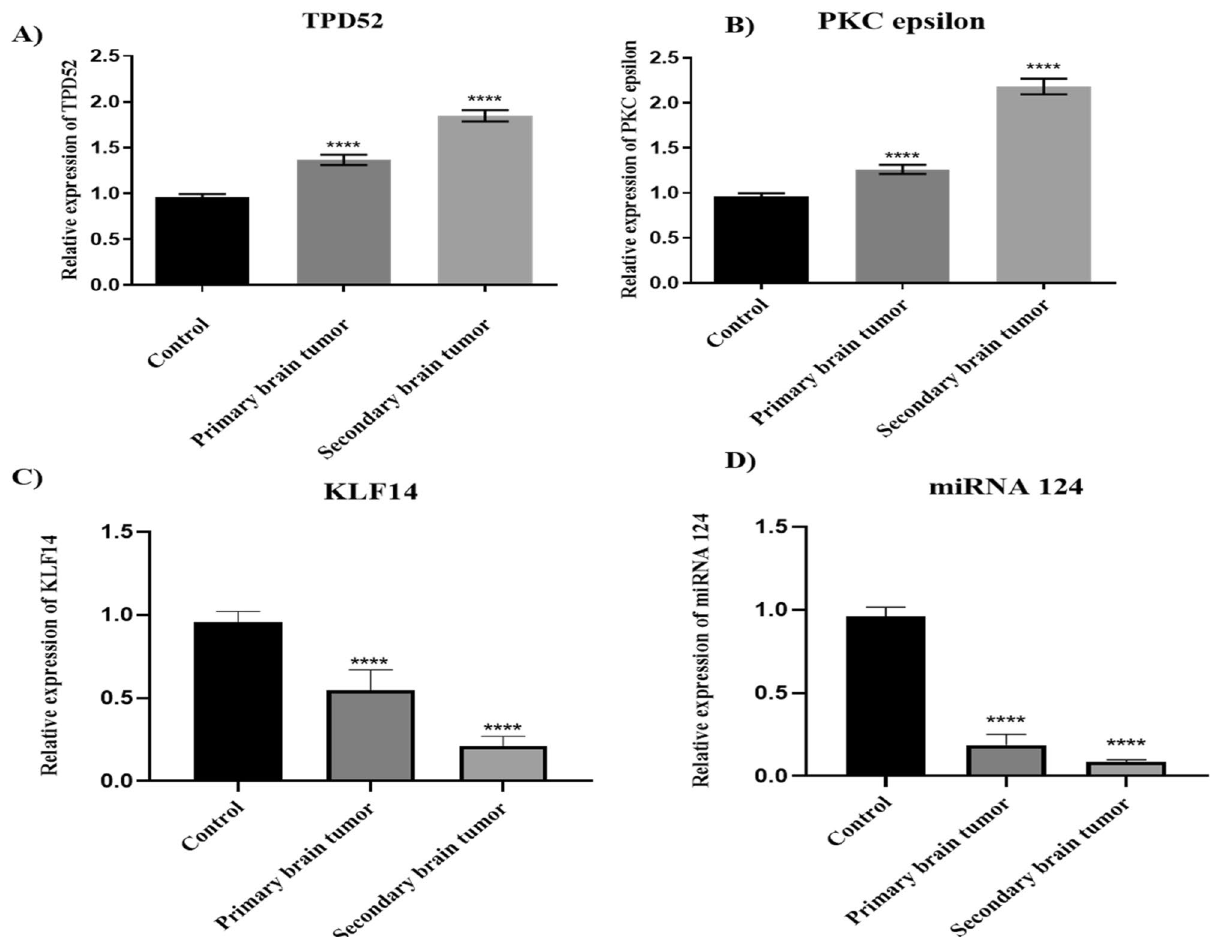
Figure 3. Expression of TPD52, PKCε, KLF14 and miRNA124 in primary and secondary groups of brain cancer. ( A ) Expression of TPD52 in metastatic and non-metastatic groups of brain cancer patients compared to healthy controls; ( B ) Expression of PKCε in metastatic and non-metastatic groups of brain cancer patients compared to healthy controls; ( C ) Expression of KLF14 in metastatic and non-metastatic groups of brain cancer patients compared to healthy controls; ( D ) Expression of miRNA 124 in metastatic and non-metastatic groups of brain cancer patients compared to healthy controls. There is an elevated expression of TPD52 and PKCε in metastatic group compared to non-metastatic group ( P < 0.0001). KLF14 and miRNA124 are low in expression in metastatic group compared to non-metastatic group ( P = 0.0005, P < 0.0001 respectively). Representative data were presented as mean ± SEM of triplicate experiments.). Statistical significance was measured by one-way ANOVA (**** P < 0.0001 and *** P < lower in both males and females in comparison to the control group (Fig. 4). However, the expression of TPD52 and PKCε were up-regulated in females in comparison to males ( P = 0.0002 and P = 0.0003, respectively). KLF14 expression ( P = 0.0027) was comparatively lower in males while miR-124 ( P < 0.0001) expression was compara- tively lower in females. Expression of TPD52, PKCε, KLF14 and miRNA-124 in space occupying lesion (SOL) of the brain. Twenty blood samples from patients with space occupying lesions (SOL) of brain were collected and analysed for expression of TPD52, miR-124 PKCε and KLF14 (Table 3). These genes were found to be differen- tially expressed. There was elevated expression of TPD52 and PKCε compared to healthy control ( p < 0.0001). The expression of TPD52 and PKCε was lower in SOL patients in comparison to patients with high grade cancer (Fig. 5A, B, respectively). KLF14 and miR-124 mRNA levels were decreased in SOL samples relative to healthy control ( p < 0.0001), but to a lesser extent than the reductions in high grade cancer (Fig. 5C, D, respectively). Expression of TPD52, PKCε, KLF14 and miRNA 124 in astrocytoma, glioblastomas, and oli-